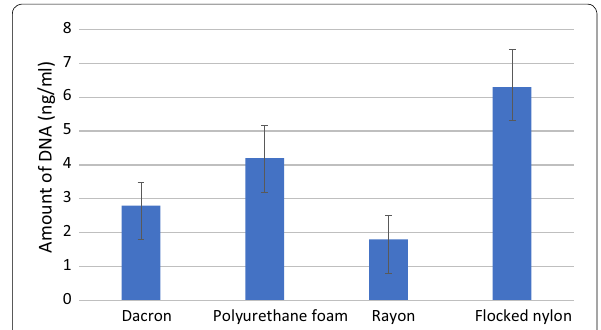
Fig. 3 Amount of DNA recovered from investigated types of swabs